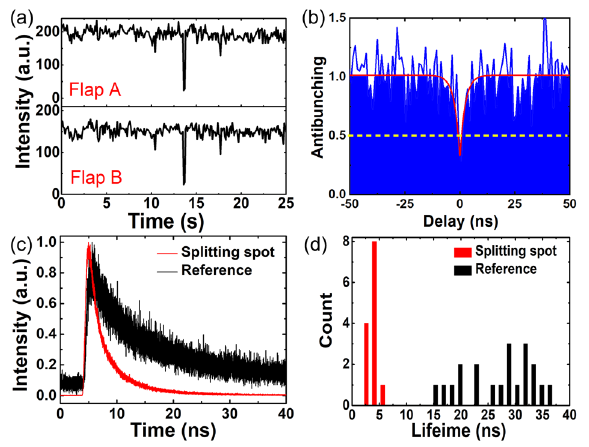
Figure 3: (a) Fluorescence intensity time traces of Flap A and Flap B in Figure 2b. (b) Autocorrelation curve of the photons emitted from the single quantum dot located above the silver nanowire. The red line is the fi tting curve. (c) Decay curves of the photons emitted from the single quantum dot. The black and red lines denote the decay curves of the photons emitted from single quantum dots doped in PMMA on glass and located above a silver nanowire, respectively. (d) Statistics of the lifetimes of the single quantum dots doped in PMMA on glass (black squares) and located above a silver nanowire (red